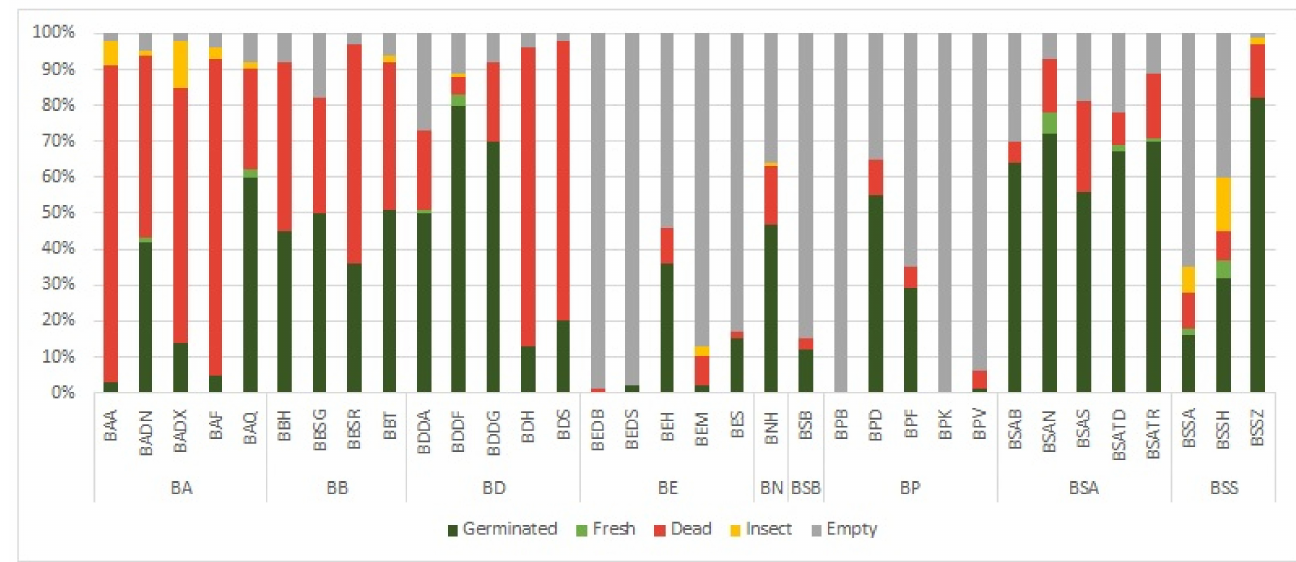
Figure 2. Seed categories proportion of all nine taxa of Boswellia collected from different localities on Socotra Island in 2021 (for abbreviations, see Table 1).